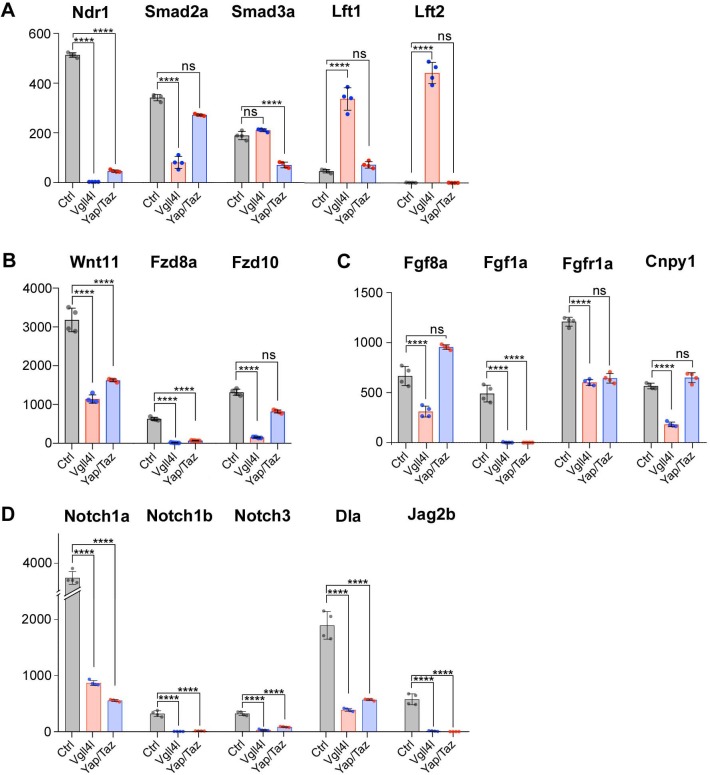
Regulation by Vgll4l or by Yap/Taz of critical genes from major signaling pathways controlling the formation of the KV.(A) Strong downregulation of nodal related 1 (ndr1) expression in Vgll4l and Yap/Taz morphants. For Vgll4l, loss of Ndr1 transcripts is associated with a strong decrease of the expression of smad2a, a R-smad known to transduce Nodal signaling, as well as to a strong upregulation of the expression of Nodal feedback antagonists, lefty1 (lft1) and lefty2 (lft2). In Yap/Taz loss of function, the strong decrease in ndr1 expression is associated with a decrease in expression of smad3a, another R-Smad transducing Nodal signaling, but not with an upregulation of ltf1/2. (B) There is a strong downregulation of expression of ligand (Wnt11) and receptors (Fzd8a and Fzd10 for Vgll4l, Fzd8a for Yap/Taz) of the non-canonical Wnt pathway. (C) Expression of ligands (Fgf8a and Fgf1a for Vgll4l; Fgf1a for Yap/Taz) and receptor (Fgfr1a) of the FGF signaling pathway is strongly downregulated in both Vgll4l and Yap/Taz loss-of-function conditions. Transcripts of the positive regulator (Cnpy1) are strongly decreased in Vgll4l loss of function. (D) The expression of ligands (Dla, Jag2b) and receptors (Notch1a, Notch1b and Notch3) of the Notch pathway is downregulated in DFCs lacking either Vgll4l or Yap/Taz. Bar graphs depict the mean expression of genes in DFCs of control (gray), Vgll4l (red) and Yap/Taz (blue) loss of function expressed as normalized counts with error bars indicating standard deviation. Dots indicate the individual value of each biological replicate (n = 4). Statistical significance between controls and the different loss-of-function conditions: two-tailed unpaired t-test. *p≤0.05, **p≤0.01, ***p≤0.001, ****p≤0.0001. ns: not significant (either p>0.05 or |log2FoldChange| < 1). Numerical data are available in Supplementary file 1.